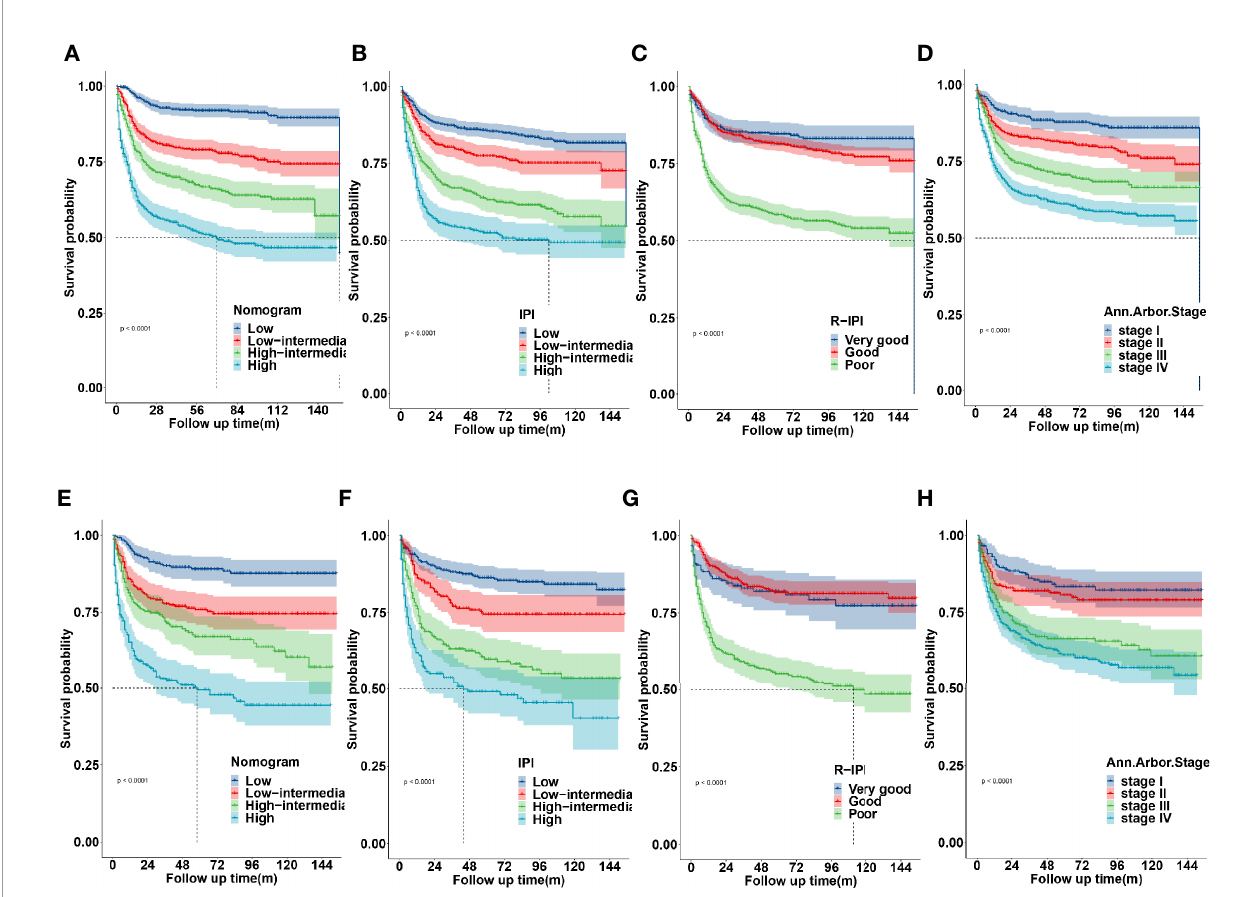
FIGURE 8 | Kaplan-Meier survival curves according to the nomogram risk level, IPI, R-IPI, and Ann arbor stage in the training (A – D) and validation cohort (E – H)